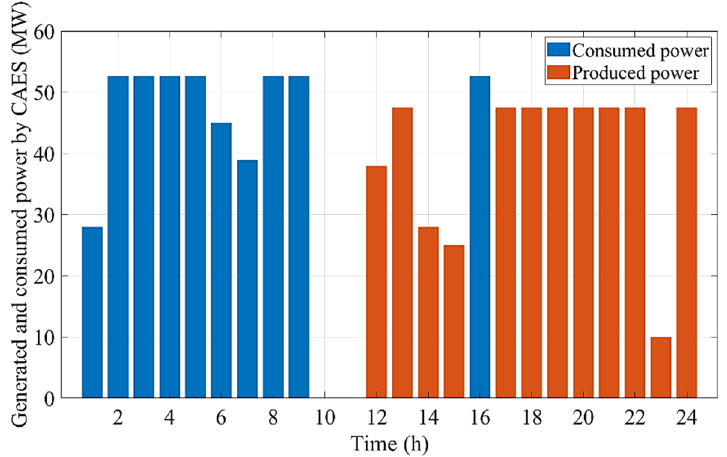
Figure 9. Amount of power consumed or produced by the CAES unit in case 4.